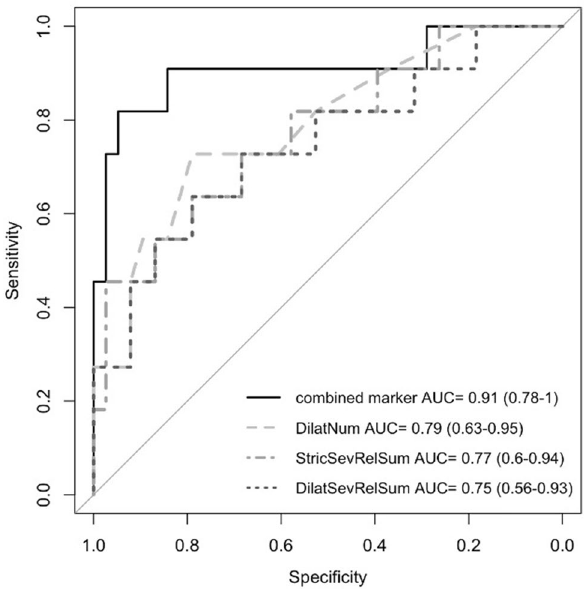
Figure 2. ROC curve of the best performing multivariable logistic regression model for discrimination of ASC from AIH (DilatNum—Total number of dilatations, StricSevRelSum—Sum of relative severity of strictures, and DilatSevRelSum—Sum of relative severity of candidate